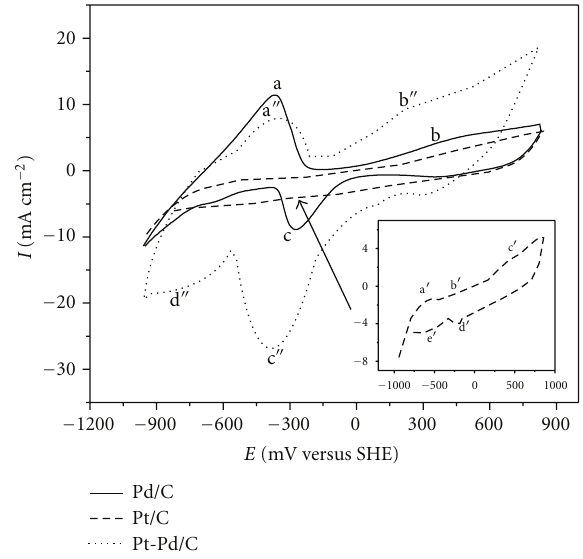
Figure 3: Cyclic voltammograms of Pd/C, Pt/C and Pt-Pd/C elec- trodes in 0.5MNaOH at 25 ◦ C and sweep rate of 50mVs − 1